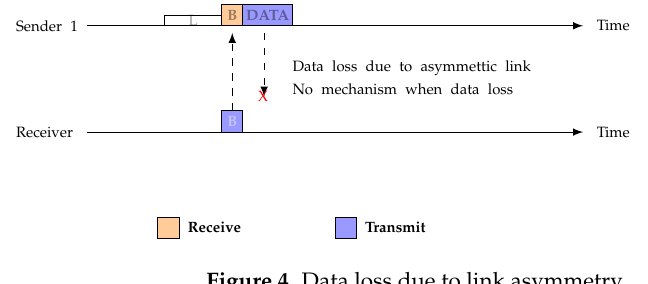
Figure 4. Data loss due to link